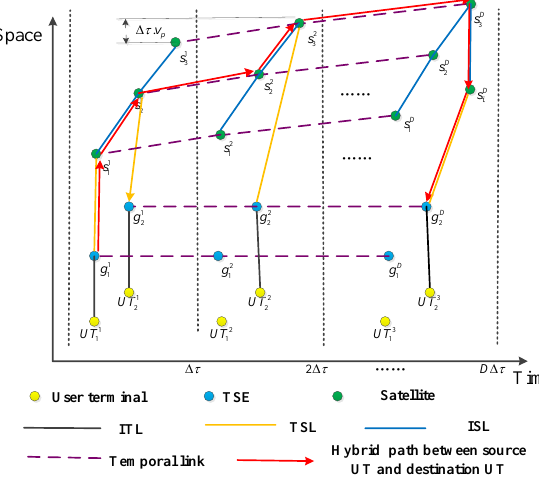
Figure 2. Space–time topology